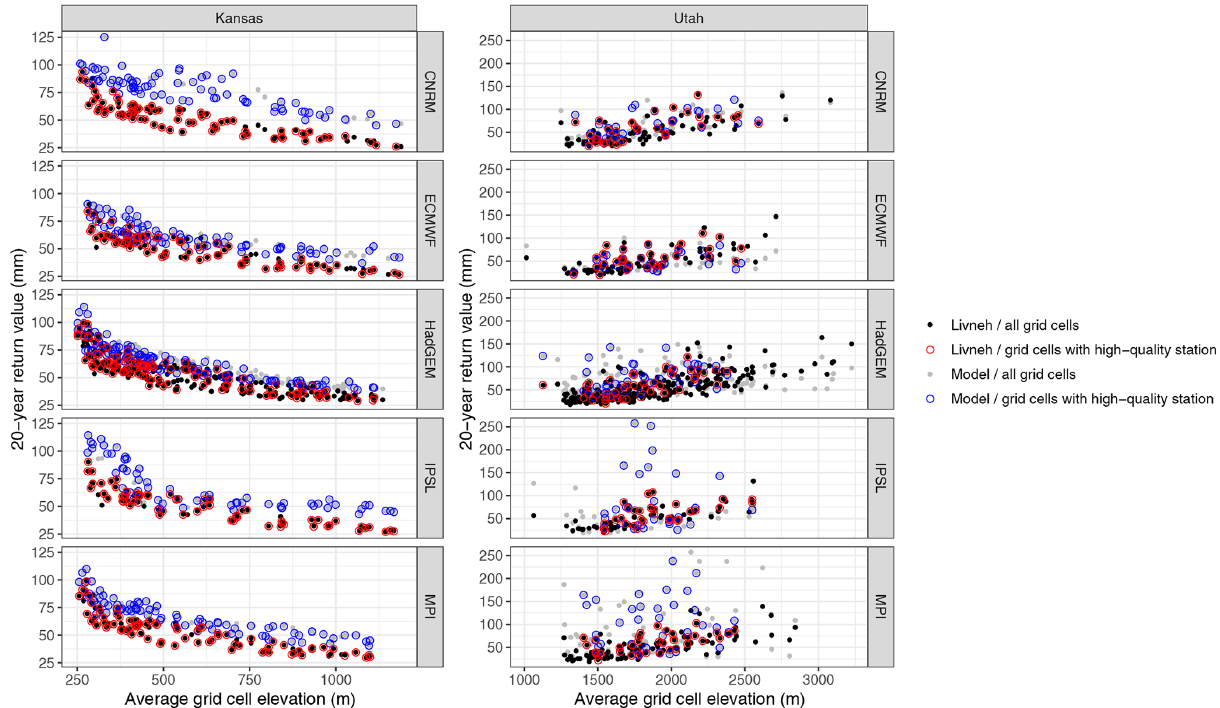
Figure A8. The distribution of the grid cell average elevation (in meters; averaged from the GTOPO30 1km digital elevation product) versus the Rx5Day 20-year return value (in millimeters) for Kansas and Utah across all model grids. Black dots represent the return values for all L15 grid cells, with gray dots representing the climate models. The colored circles (red for L15 and blue for the models) identify the grid cells that have at least one high-quality station and are used in the true model performance metrics.